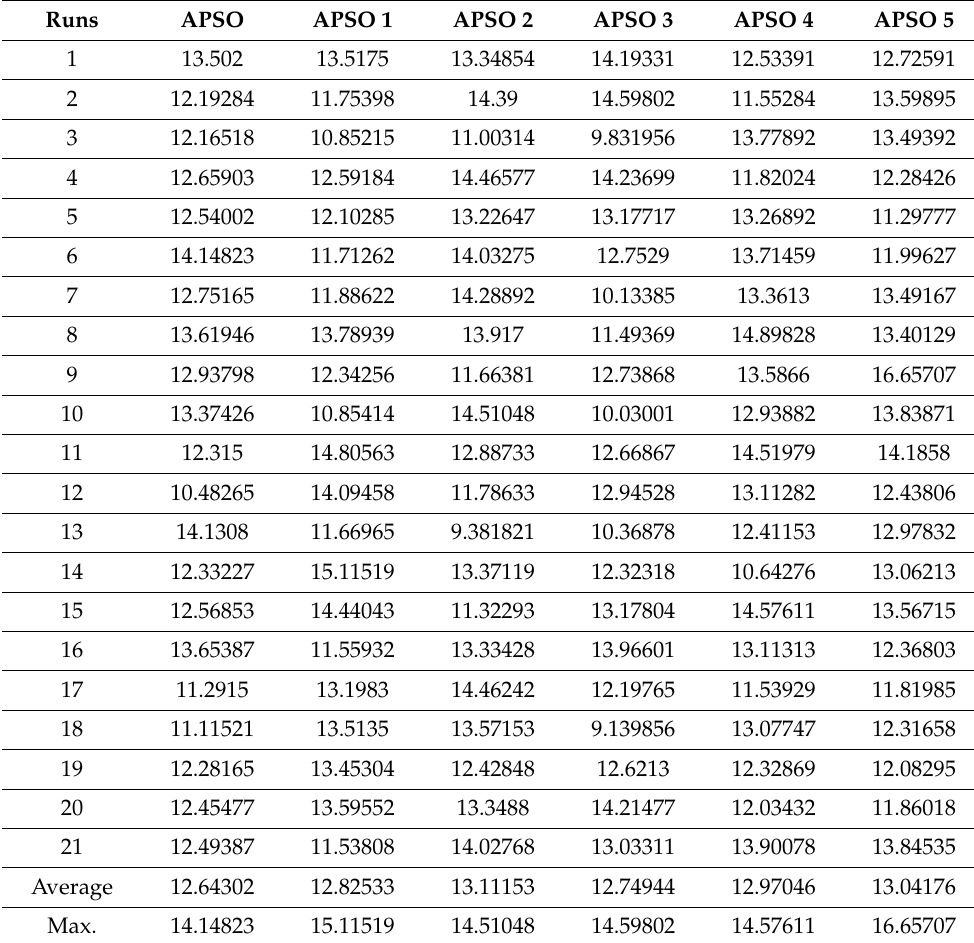
Table 5. APSO and its variants’ results for 50 PHEVs (30